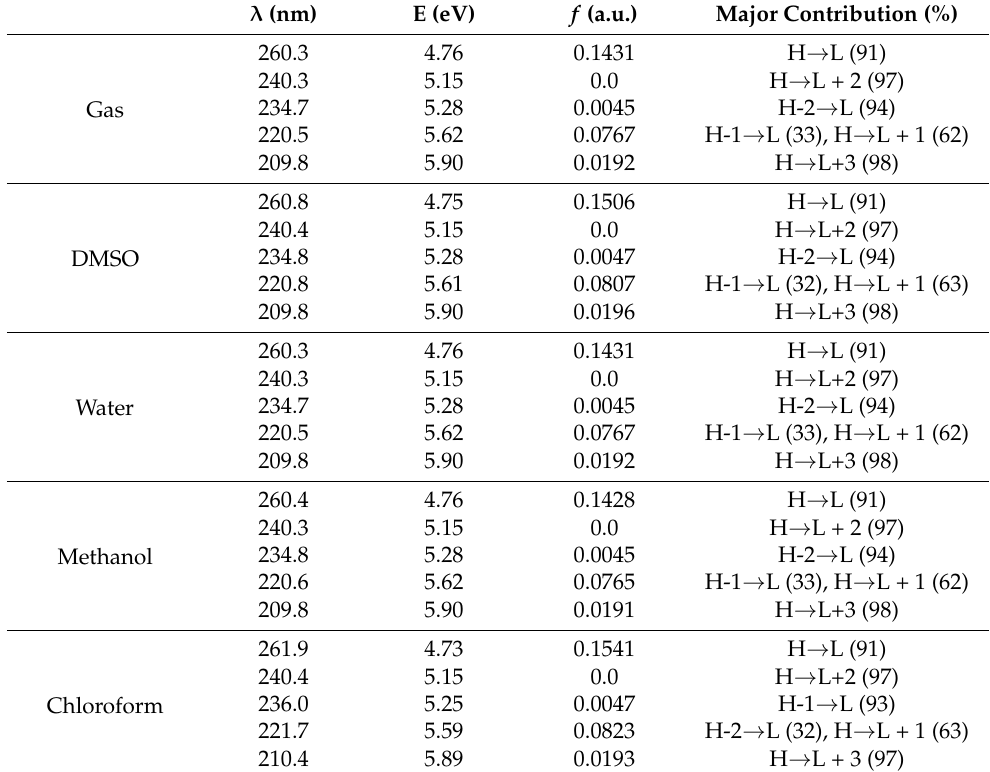
Table 4. Calculated parameters of the absorption wavelength ( λ ), excitation energies (E) and oscillator strengths ( f ) of 3-Br-2-HyP compound using DFT